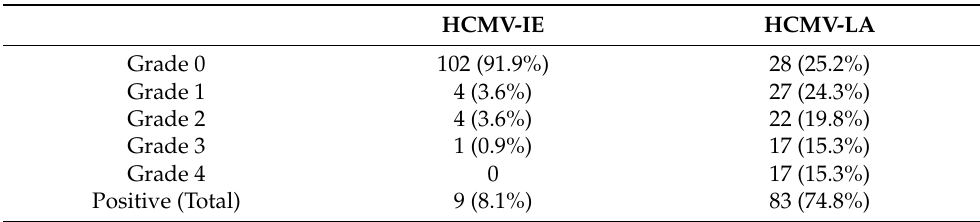
Figure 3. Demonstration of HCMV IE and LA in breast cancer tissue specimens by using an automated IHC approach. Approximately estimated number of the tumor cells expressing HCMV-IE and LA within the breast tumor sections are scored as 0; <1%, 1; 1–24%, 2; 25–49%, 3; 50–74%, and 4; >75%. HCMV IE and LA (brown color) are expressed in the cytoplasm of the tumor cells. There was no HCMV IE grade 4 among our specimens. Original magnification ×20. Table 2. Results of HCMV IE and LA positivity in breast cancer specimens and breast cancer metastases, n =